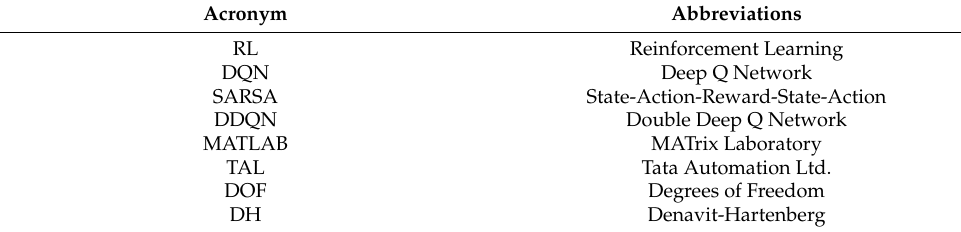
Table A3. List of